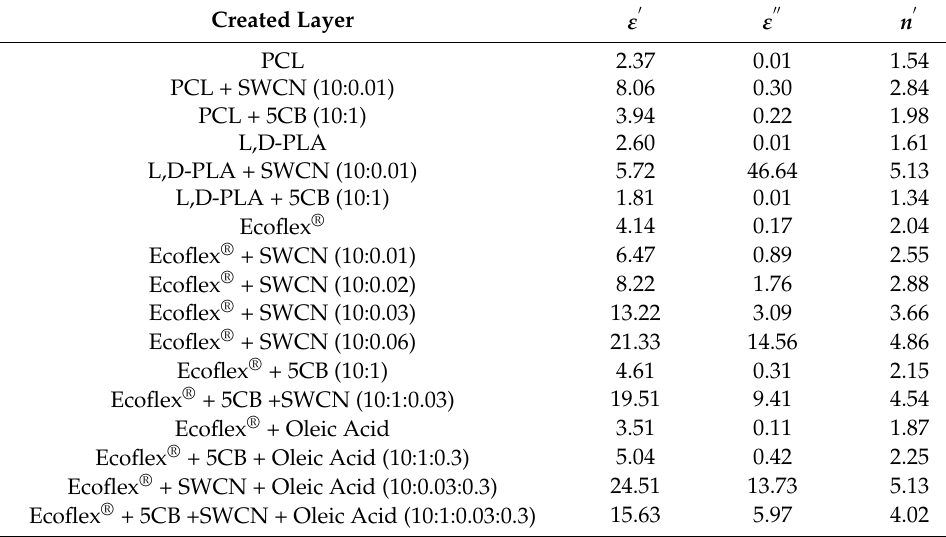
Table 1. Estimated refractive index n (cid:48) at 1